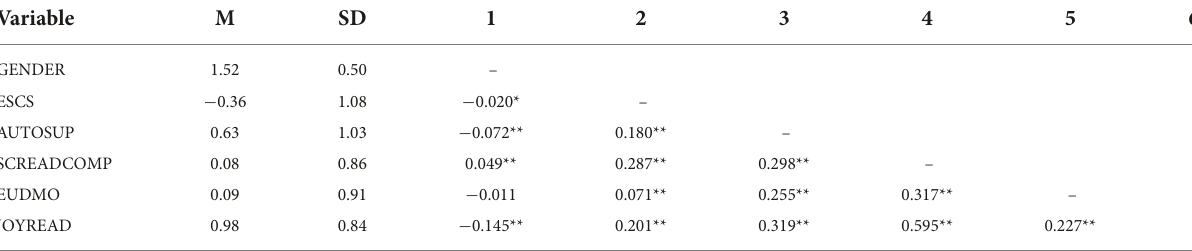
TABLE 1 Descriptive statistics and correlation matrices among variables.